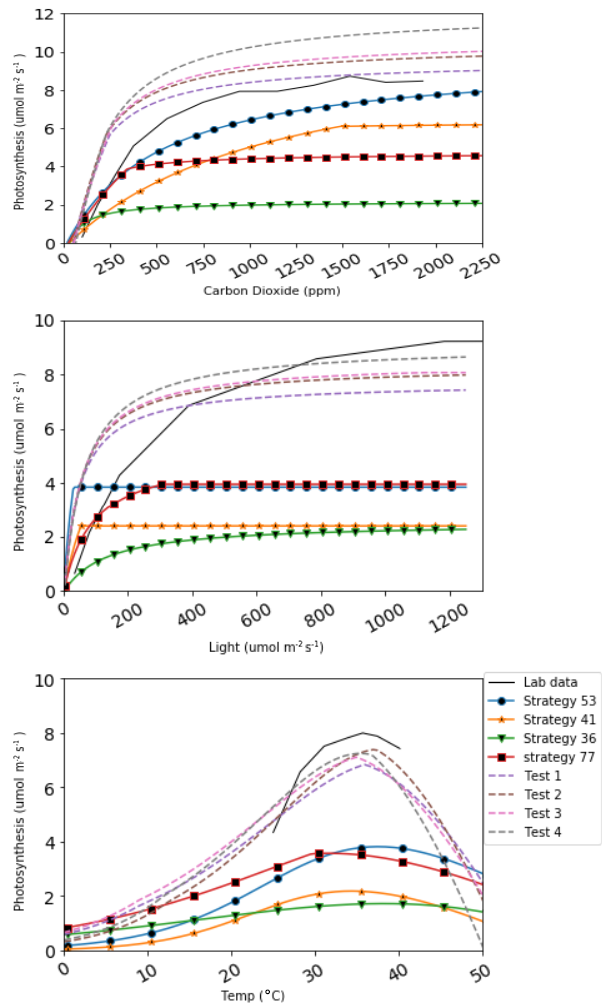
Figure 5. CO 2 , light, and temperature responses of four lycophyte strategies simulated (colored solid lines) in LYCOm against the four best test strategies (dashed lines) generated from LYCOm parame- terization ranges in order to replicate the lab data (in black solid line; Soni et al. (2012)) as closely as